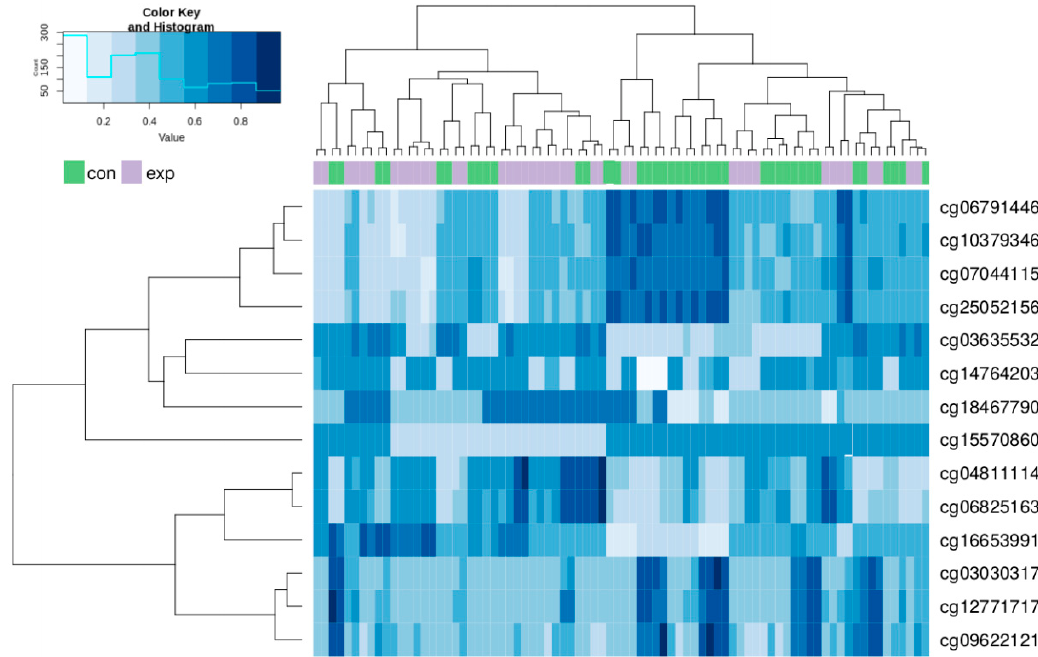
Figure 4. Hierarchical clustering analysis of the most differentially methylated CpG loci in the exposed and control group. Columns represent individual samples (exposed, purple; controls, green); methylation intensities in individual CpG sites identified by cg numbers are in rows.